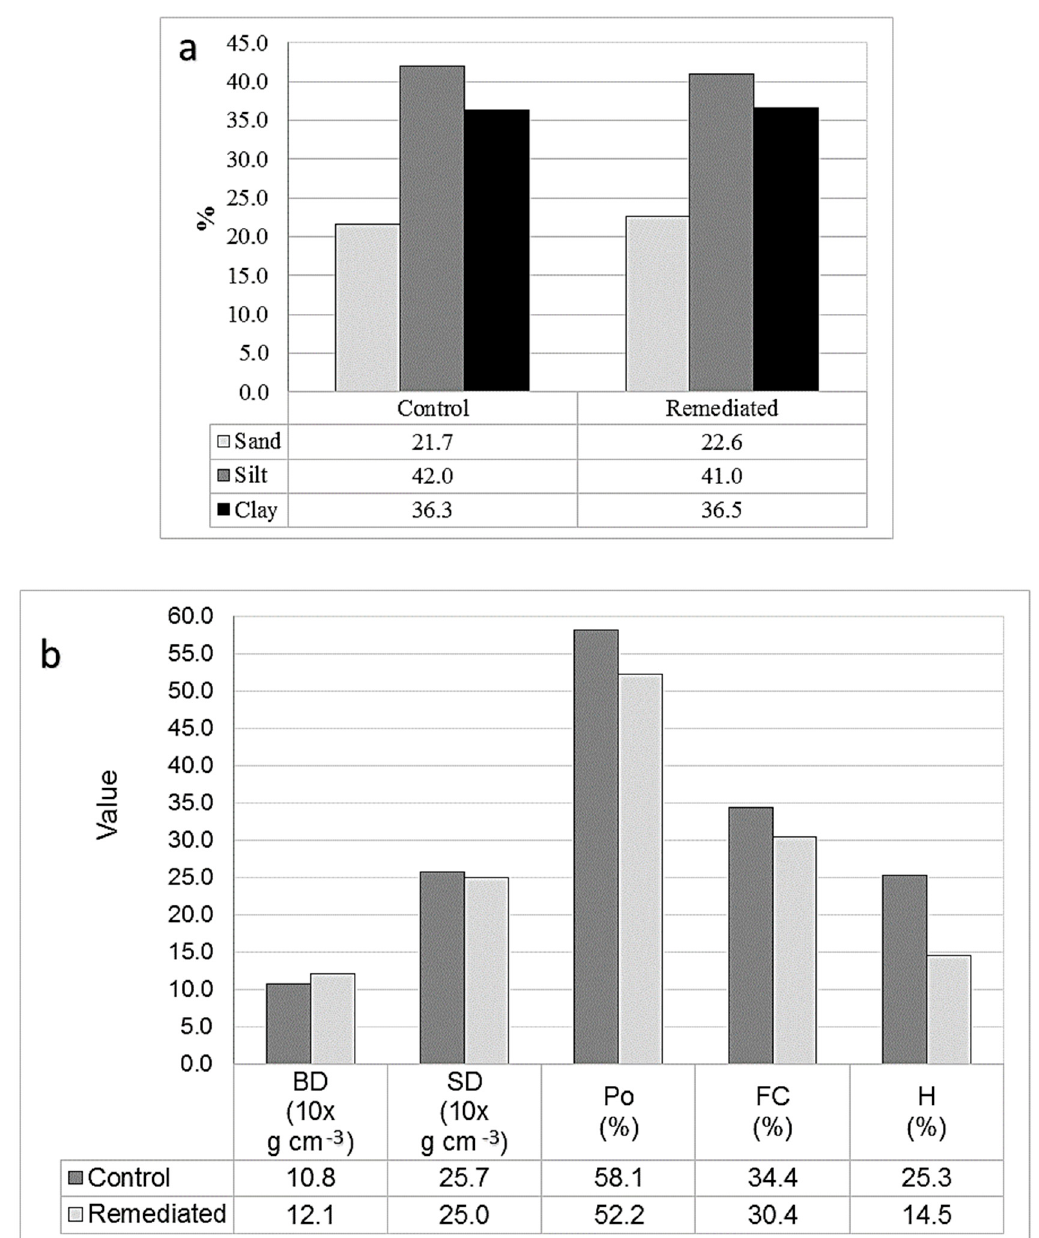
Figure 3. Control and remediated soil profile (weighted averages of 0–3 m soil depth) ( a ) texture and ( b ) bulk density (BD), particle density (SD), porosity (Po), field capacity (FC), and moisture content (H) values.